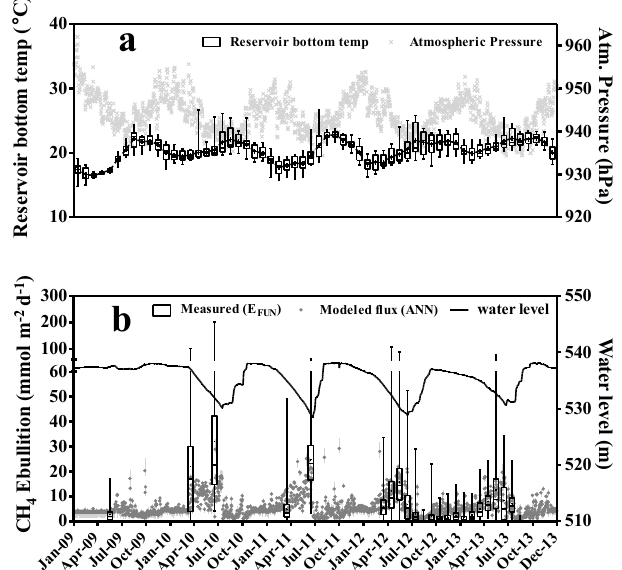
Figure 9. Time series of the (a) reservoir bottom temperature and at- mospheric pressure, and (b) funnels measured and ANN-modelled ebullition fluxes along with the reservoir water level. In panel (b) , the boxes show the median concentration and the interquar- tile range, and whiskers denote the full range of all values. The plus signs ( + ) in the boxes of panels (a) and (b) show the mean value.